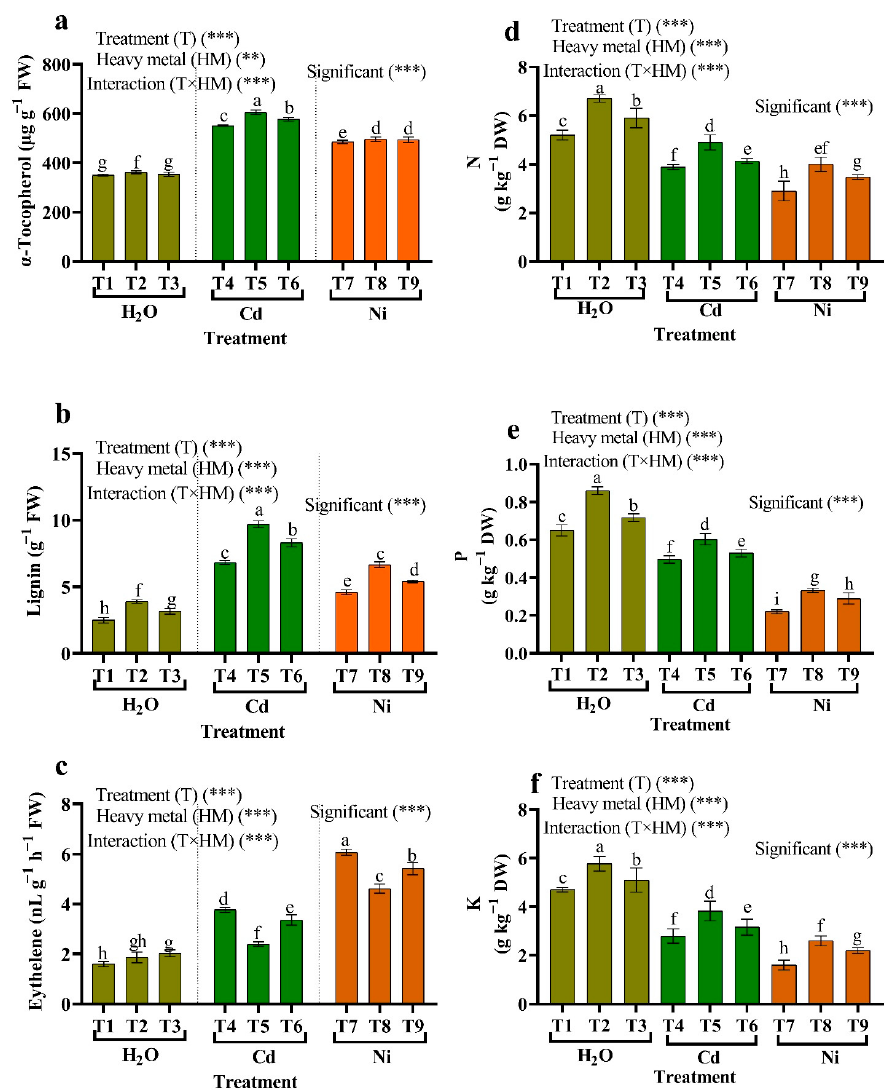
Figure 7. The influence of two endophytic bacteria on ( a ) α -Tocopherol, ( b ) lignin, ( c ) ethylene, ( d ) nitrogen (N), ( e ) phosphor (P), and ( f ) potassium (K) content in tomato plants growing under HM stress. Fishers test at p < 0.05 reveals significant variations in means ( ± standard error) of different letters (a–i) on the same bars Thus, ** and *** imply significance levels of 0.01 and 0.05, respectively. T1: (Control with tap water), T2: Micrococcus luteus , T3: Enterobacter cloacae , T4: 50 μ M Cd, T5: Micrococcus luteus + 50 µ M Cd, T6 : Enterobacter cloacae + 50 µ M Cd T7: 50 µ M Ni, T8: Micrococcus luteus + 50 µ M Ni, T9 : Enterobacter cloacae + 50 µ M